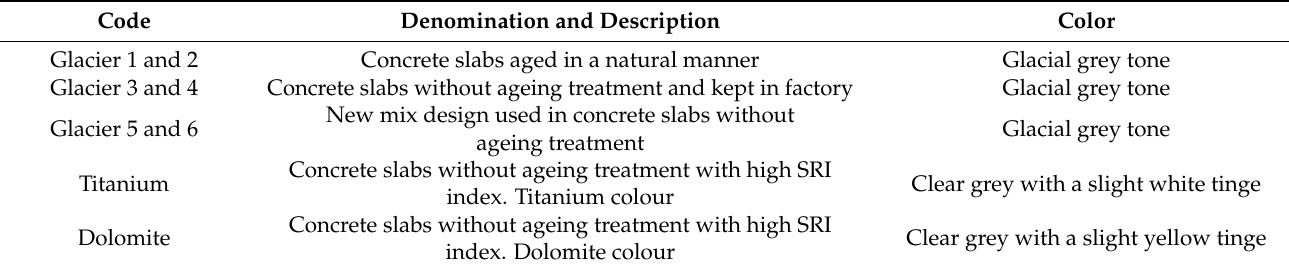
Table 2. Description and codification of the tested